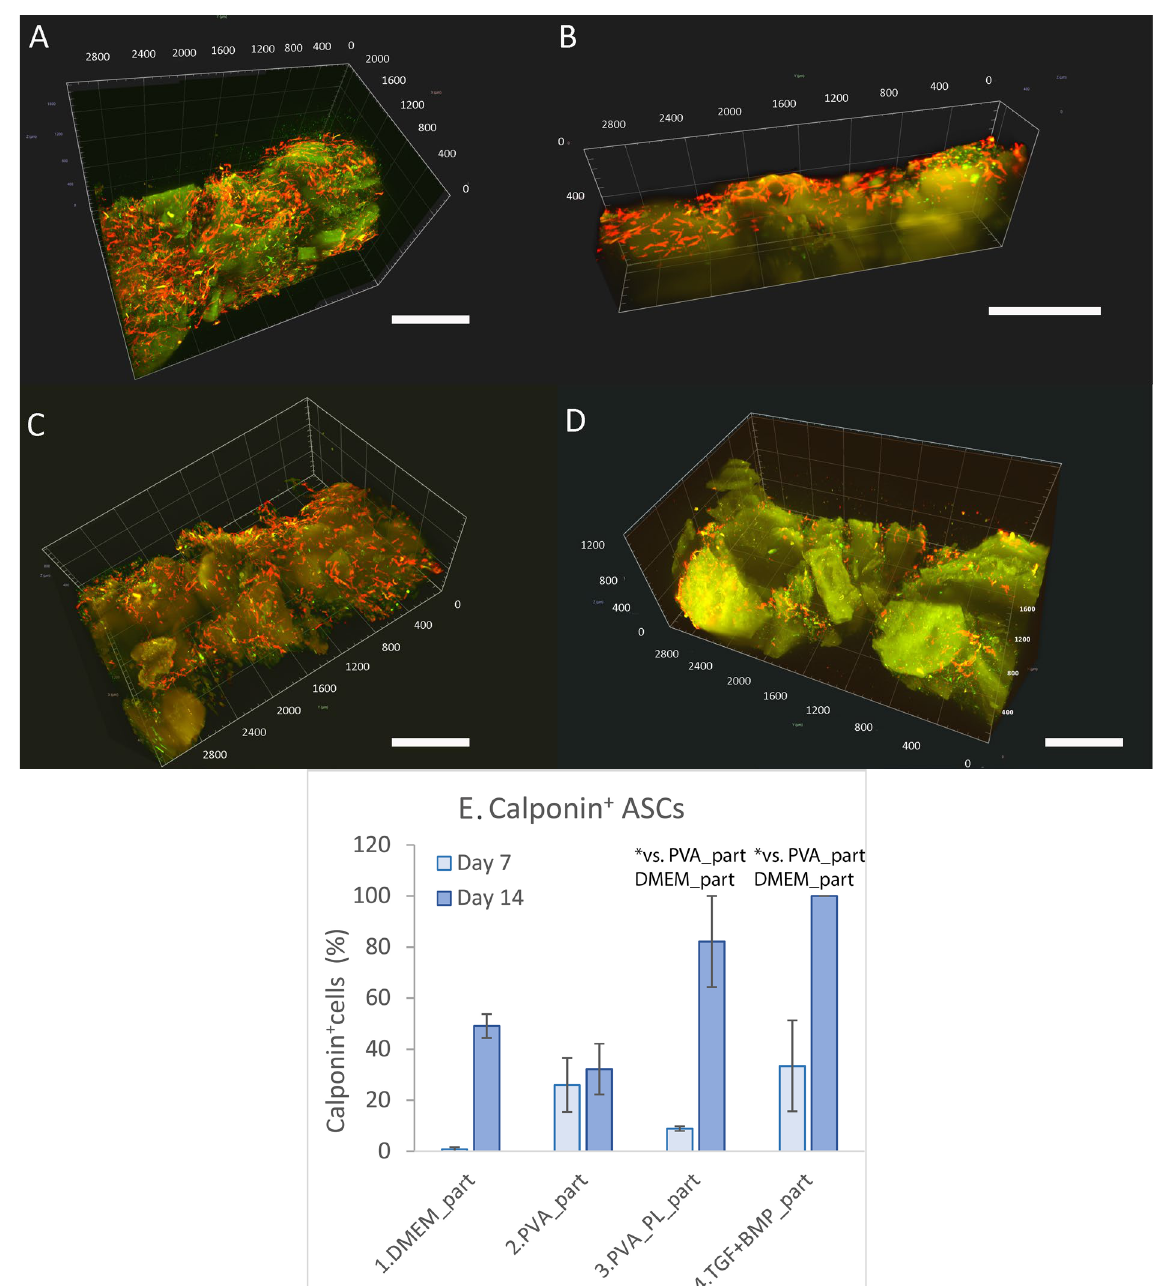
Figure 8. Immunofluorescence staining of alpha-actin (red) and calponin (green) in ASCs in collagen gels with collagen particles on day 7. The cells were cultured in DMEM with 2% of FS ( A ), in medium with added PVA nanomats ( B ), with added PVA_PL nanomats ( C ) or in medium supplemented with TGF- β 1 + BPM-4 ( D ), scale bar = 800 µm. Percentage of calponin + cells in collagen gels on days 7 and 14 ( E ). Cell nuclei were counterstained with DAPI. Zeiss Z.1 lightsheet microscope, obj. × 10 for excitation, obj. × 20 for detection, zoom × 0.4 tile scans. Data are expressed as mean ± S.D. Statistical significance is considered for * p -value < 0.05 in comparison with the sample of the same number, and is depicted above the graph columns.